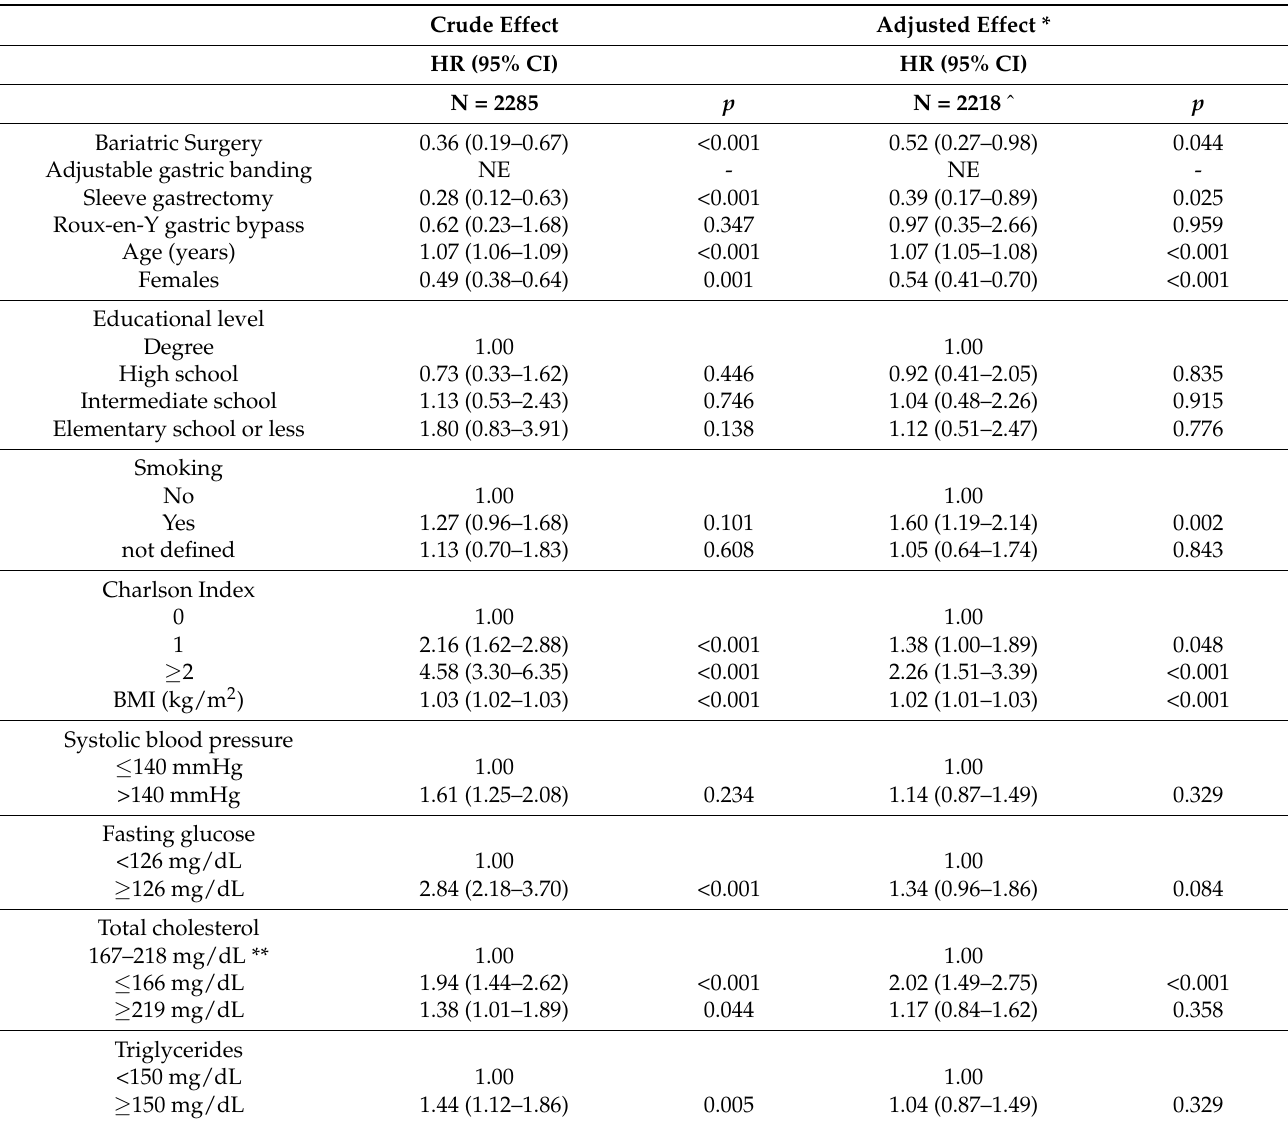
Table 2. Association (HR and 95% CI) between baseline characteristics, bariatric surgery (as time dependent variable) and all-cause